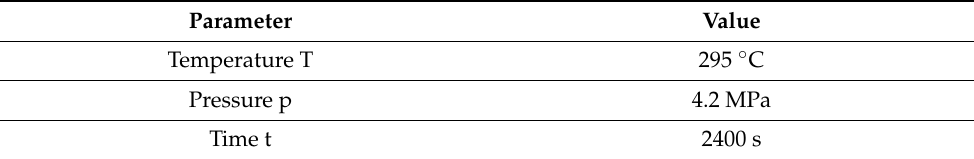
Table 1. Parameters for pressing cycle of the demonstrator part